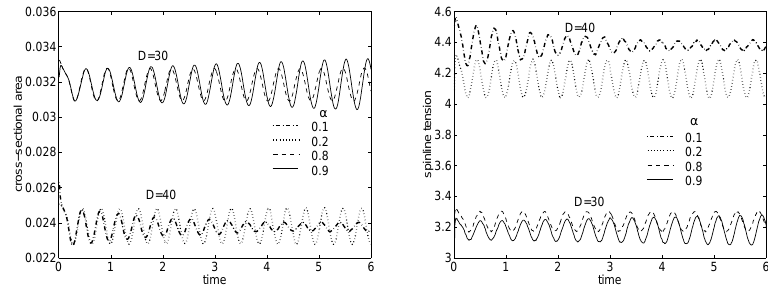
Figure 3. Transient response of the cross sectional area (left) and spinline tension (right) at take-up for different values of α .